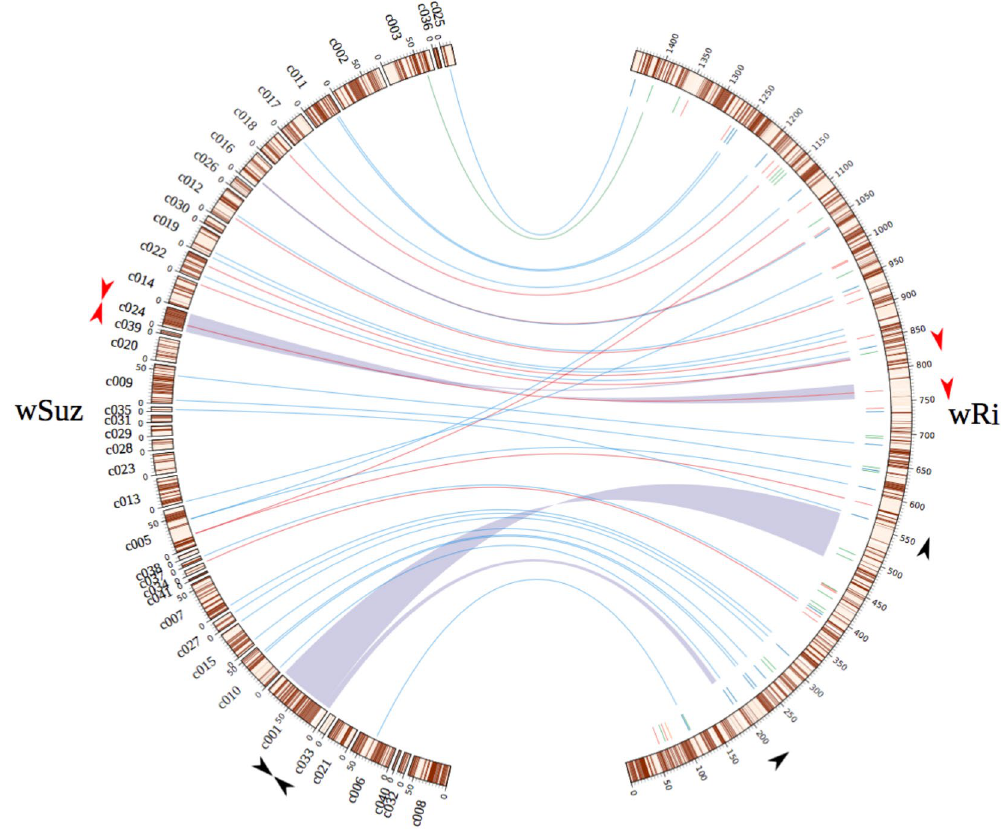
Figure 1. Genome comparison of w Suz and w Ri for candidate marker loci selection. w Suz contigs have been oriented according to w Ri genome. Annotated CDSs in either plus or minus strand are represented with brown and cream colored boxes respectively. The grey twisted ribbons represent the two genomic rearrangements detected in w Suz relative to w Ri. The orientation of the primers used for validating GR1 and GR2 in both genomes are represented with black and red arrowheads respectively. The inner circle in w Ri genome represents annotated IS elements, color-coded based on their group affiliation (red: ISWpi1, green:ISWpi2, orange:ISWpi4, blue: ISWpi5 and purple: ISWpi7). Colored lines linking w Ri to w Suz genome represent the 32 polymorphic IS loci used in the present study. The graph was designed with Circos software 81